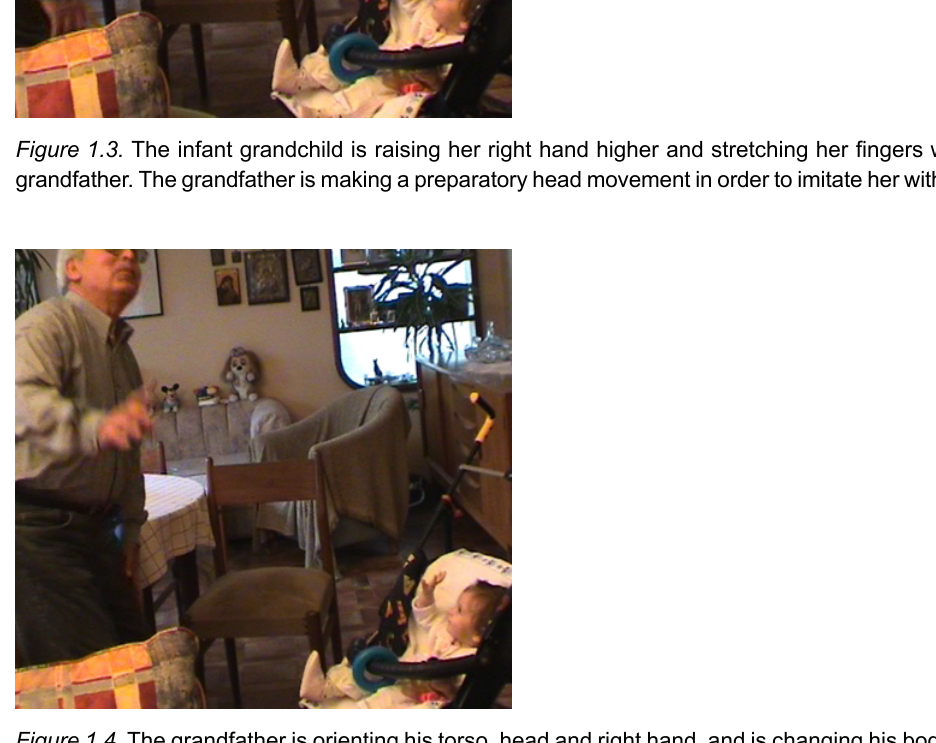
Figure 1.4. The grandfather is orienting his torso, head and right hand, and is changing his body posture to an upright position, in order to imitate his infant grandchild’s hand movement while he is still smiling. The infant is keeping her right hand up while she is focused on